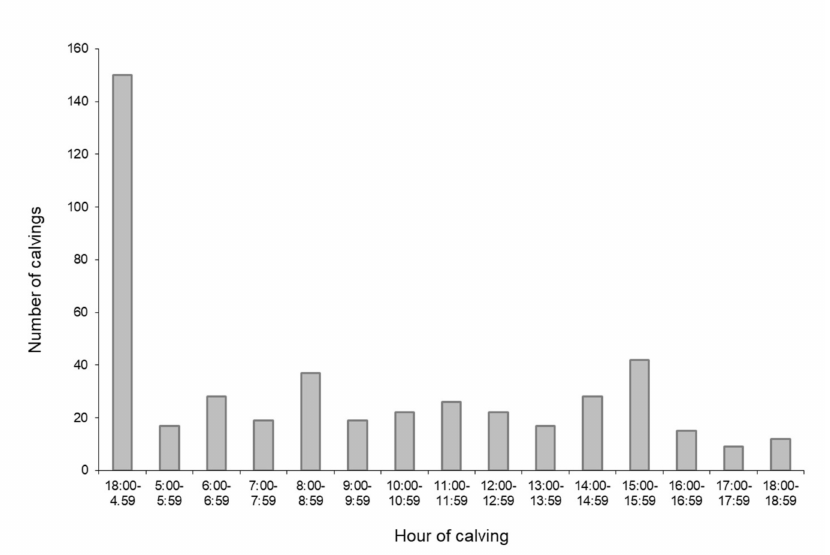
Figure 2. Distribution of calving hour during the